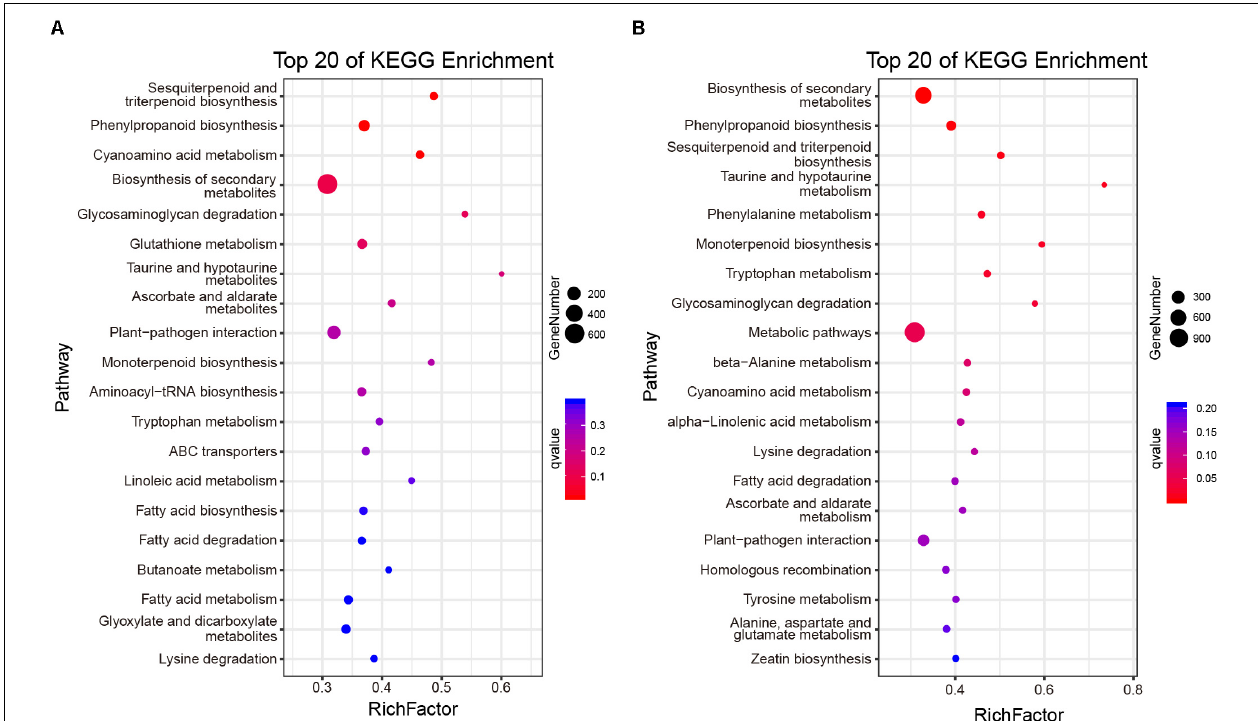
FIGURE 4 | KEGG functional categorization of the positive selection gene. (A) Enrichment analysis of positive selection genes of CSS subgroups. (B) Enrichment analysis of positive selection genes of CSA